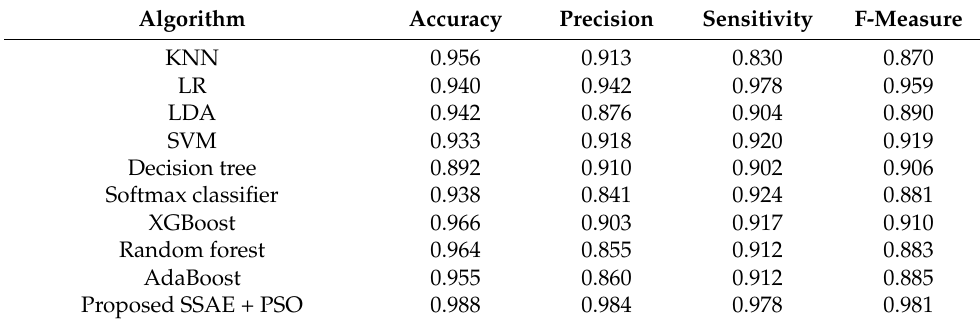
Table 5. Assessment of the performance of the algorithms using the cervical cancer dataset.